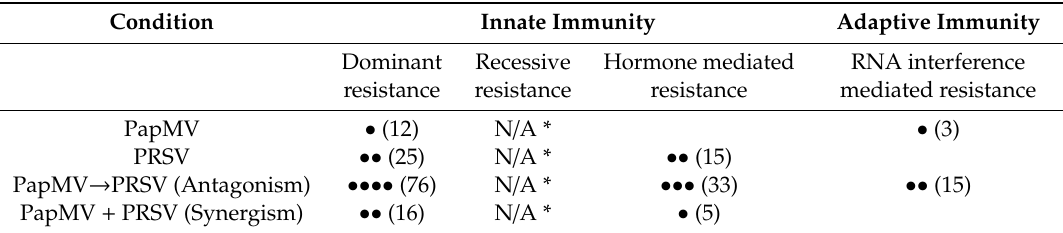
Table 1. Number of di ff erentially expressed genes associated with immunity and resistance under